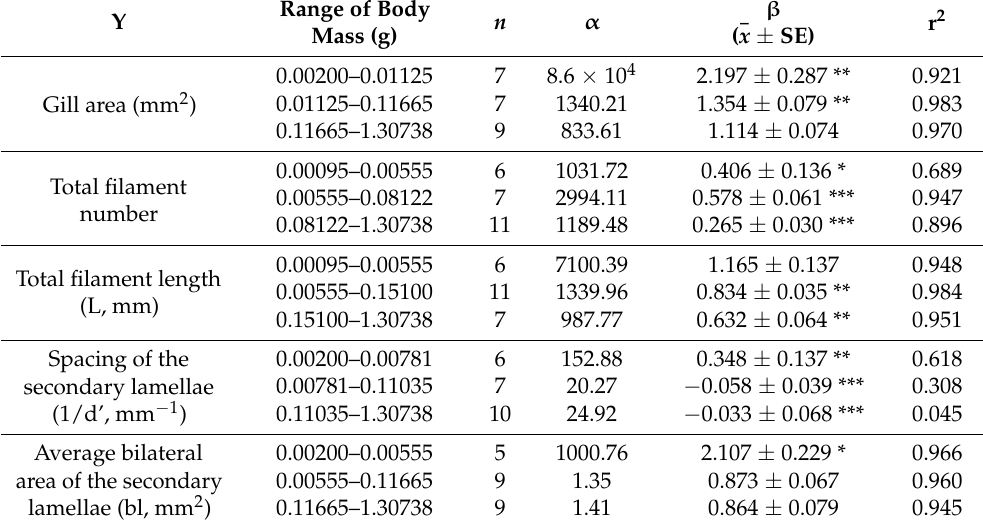
Table 1. Regression analyses of the allometric relationship (Y = α M β ) between gill dimensions (Y) and body mass (M).